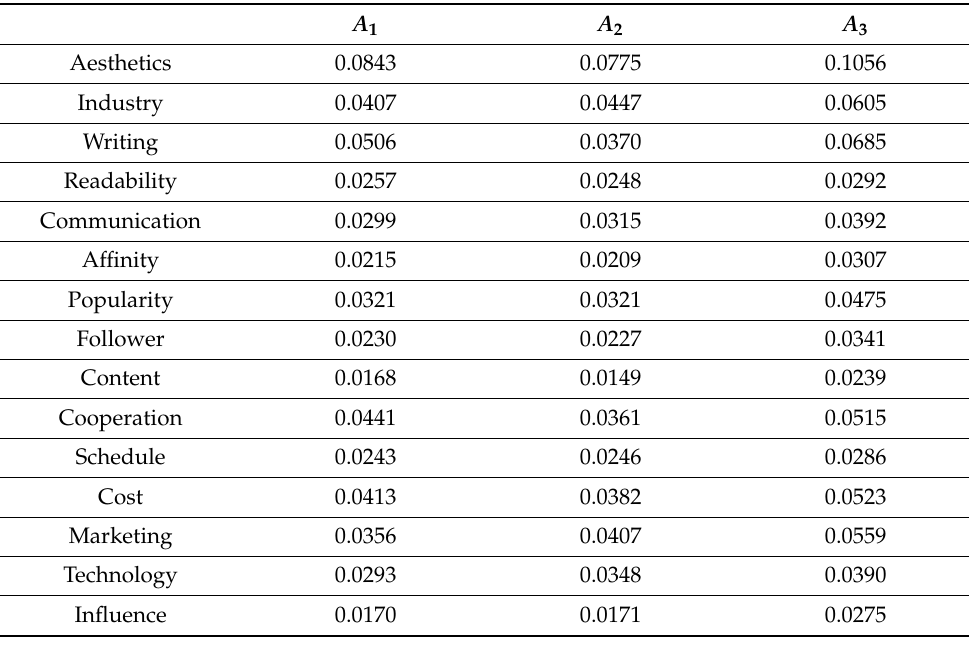
Table 7. The weighted normalized evaluation value.